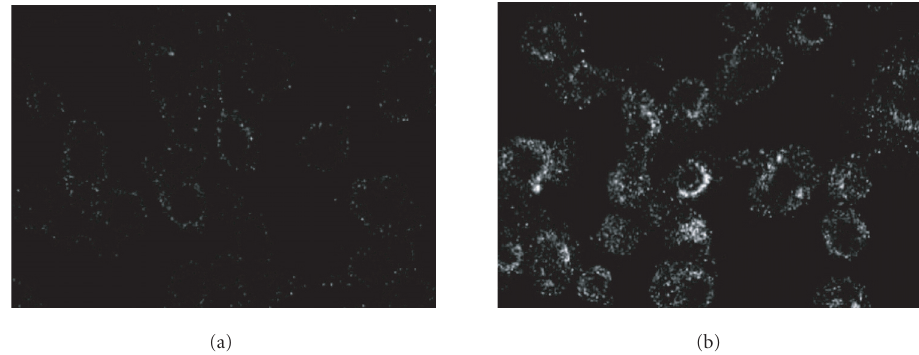
Figure 4. E ff ect of DNFB on IL-1R immunoreactivity. (b) IL-1R immunoreactivity in FSDCs after exposure to 2,4- dinitrofluorobenzene (DNFB, 1 µ g/mL), for 30 minutes. (a) Control cells were maintained in medium alone. Cells were immunos- tained with an anti-IL-1R type I and type II antibody, as described in “materials and methods.” The figures are representative of the results obtained in three independent